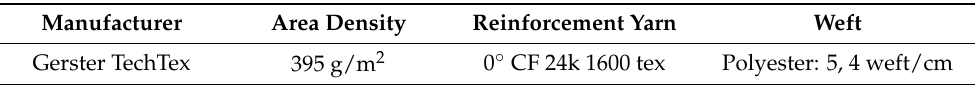
Table 1. Specification of the unidirectional non-crimp fabric (UD-NCF).